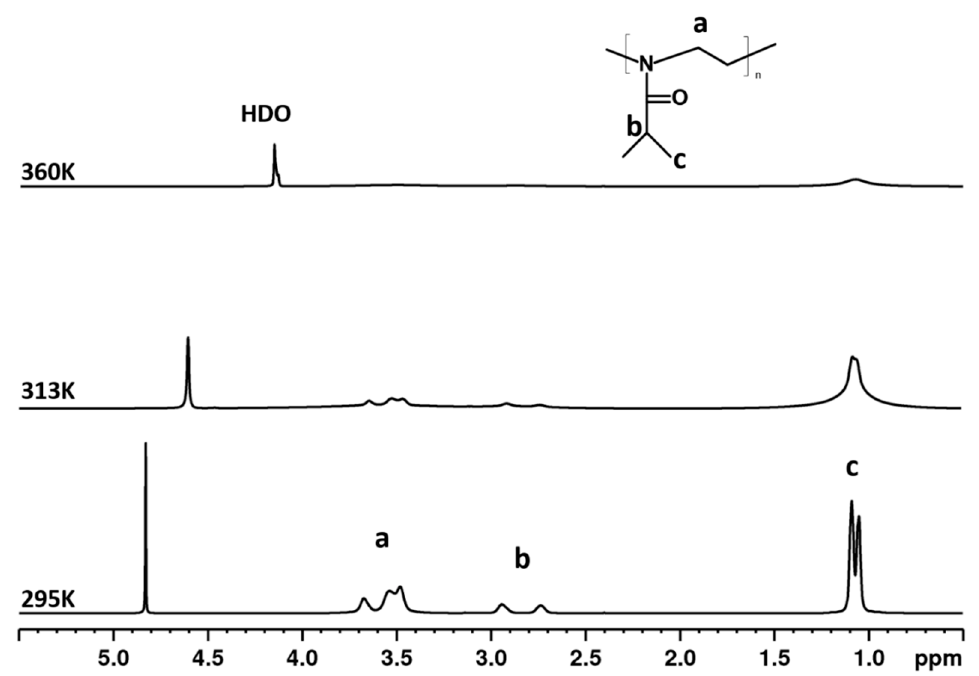
Figure 2. 600.2 MHz 1 H NMR spectra of PIPOx homopolymer in D 2 O solution ( c = 5 wt%) measured at 295, 313, and 360 K under the same instrumental conditions.